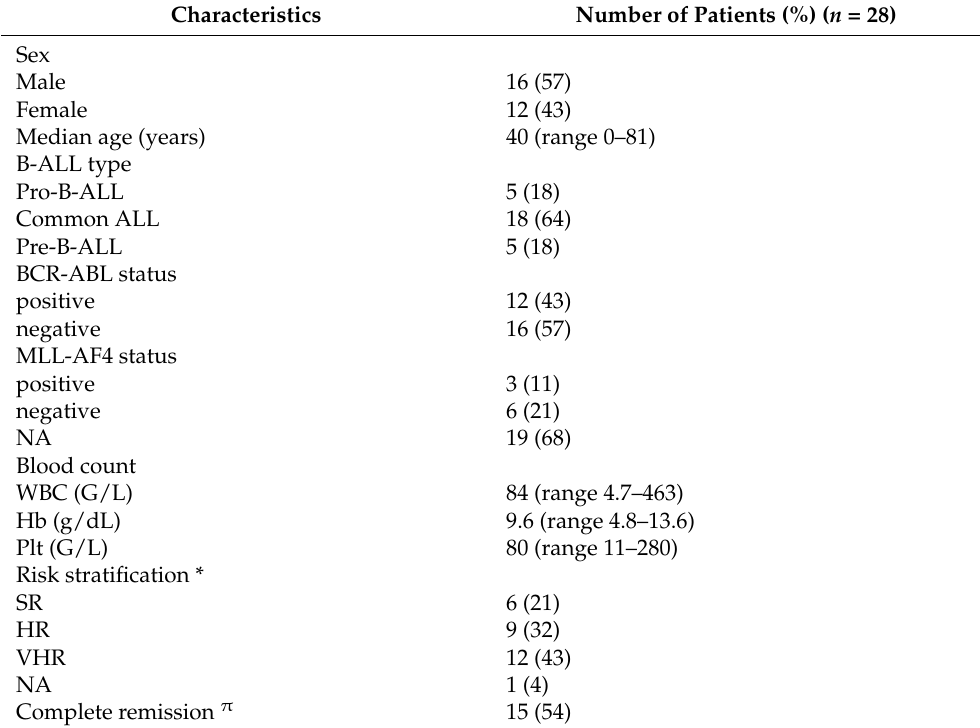
Table 1. Patients